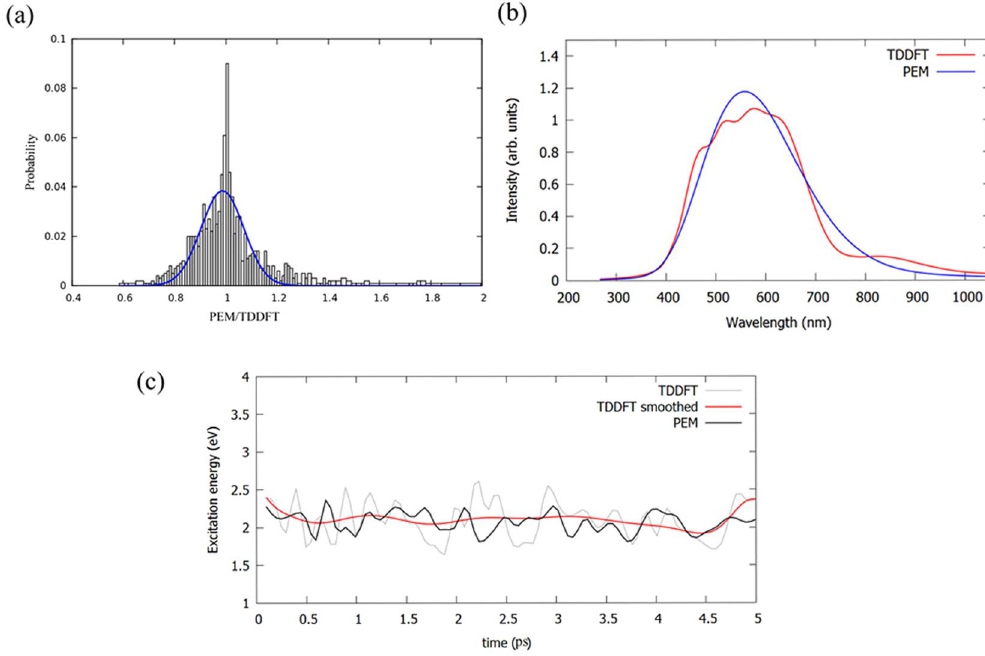
Figure 6. ( a ) The ratio distribution of the excited energy (ratio = PEM v.s . TDDFT). The blue curve is fitted with Gaussian function ( μ = 0.99, σ = 0.08). ( b ) The fluorescence emission spectra roughly estimated from PEM and TDDFT. ( c ) The time evolution of the excitation energy calculated at PEM and TDDFT level. The red line is the TDDFT result smoothed with Bézier curve, in order to remove the fast